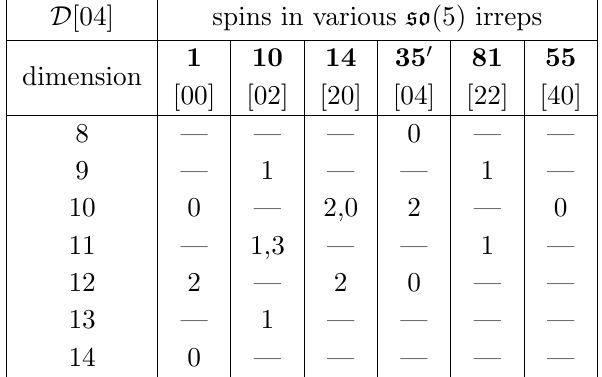
Table 5 . All possible conformal primaries in D [20] (cid:2) D [20] corresponding to the D [04] supercon- formal multiplet.